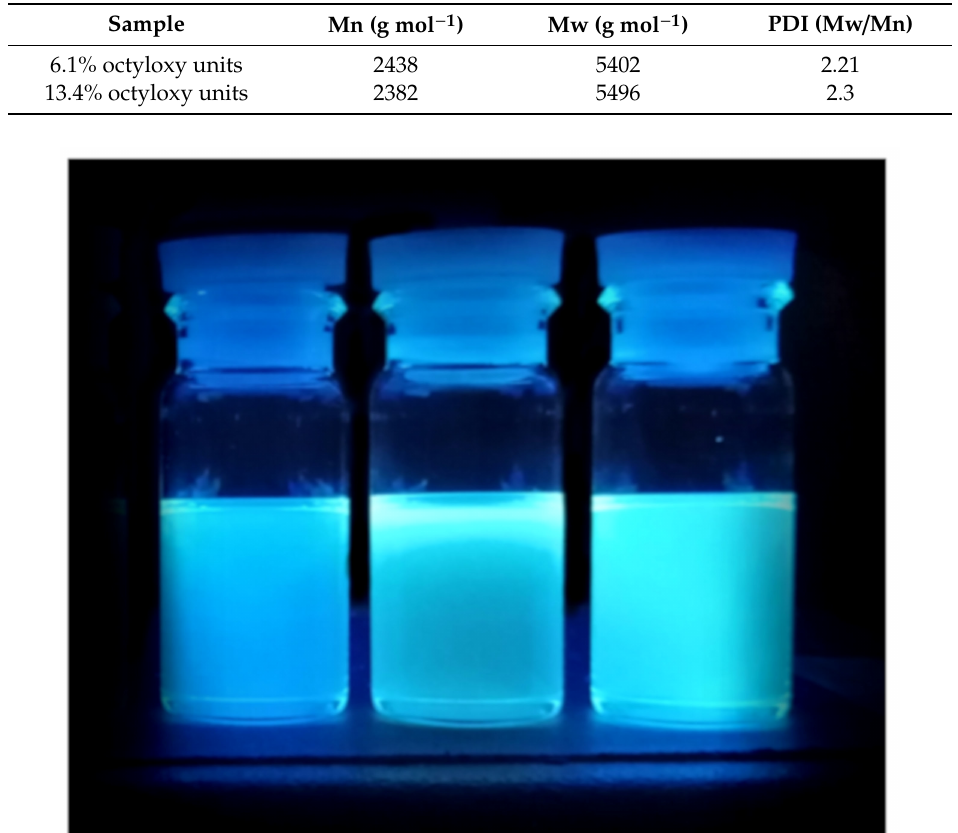
Figure 2. Photographs taken under UV-light illumination of PPM and its derivatives solutions in chloroform ( ≈ 0.5% m / m, 2 cm diameter of the vials): PPM (left), copolymer containing 13.4% (center) and 6.1%